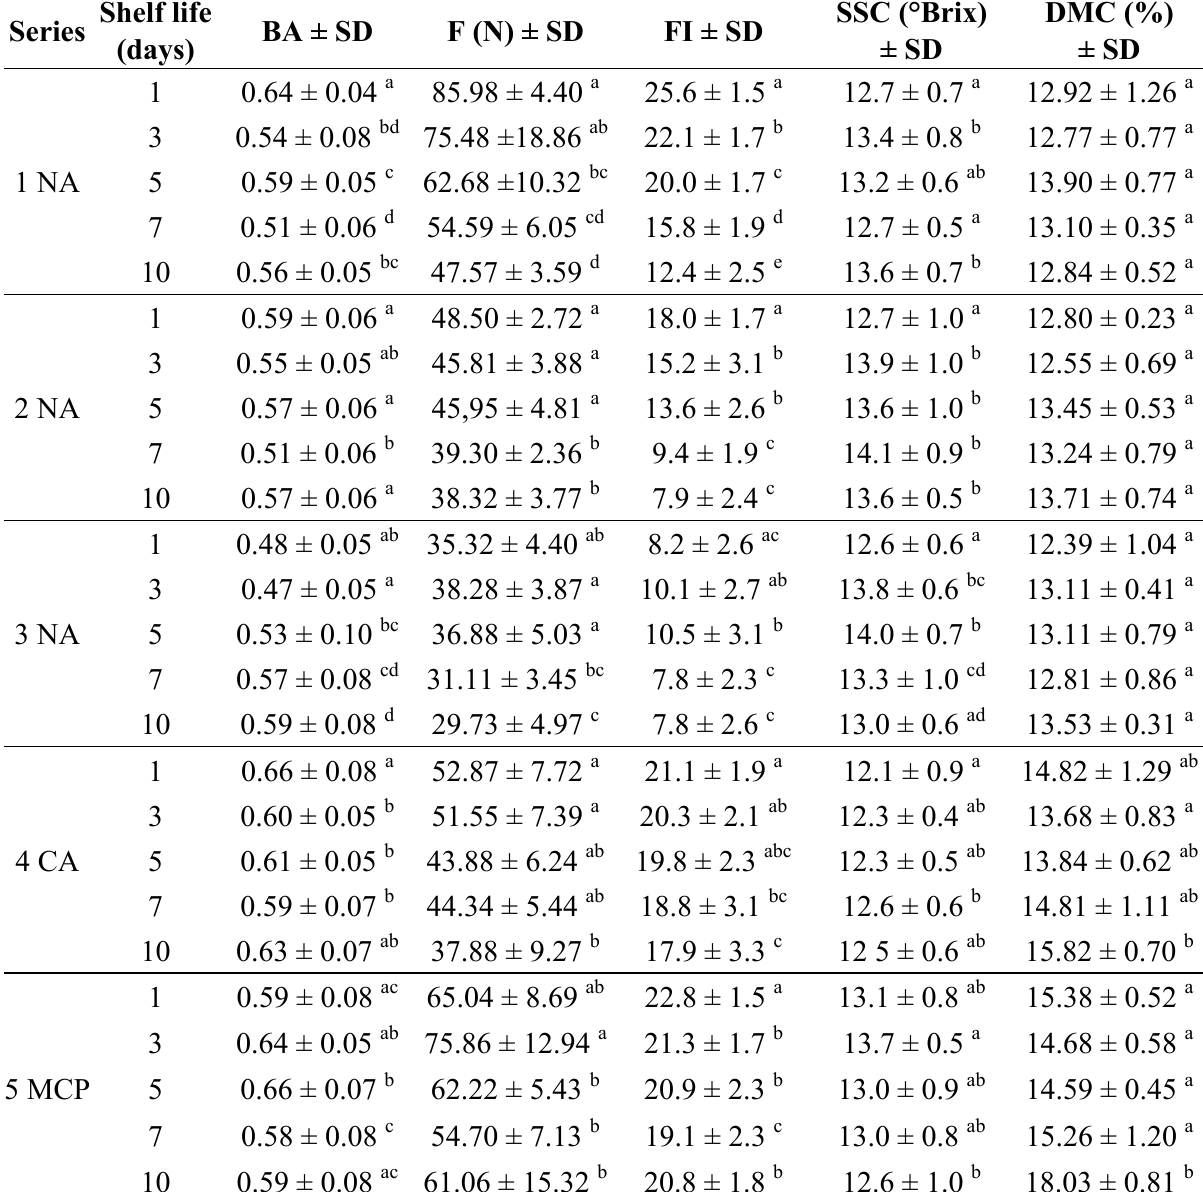
Table 2. Mean values of biospeckle activity (BA) and quality attributes for ‘Topaz’ (F–firmness, FI–firmness index, SSC–soluble solids content, DMC–dry matter content) of apple during shelf-life. SD–standard deviation, the same letters a–e mean no significant difference at the level of α = 0.05 between superscripted